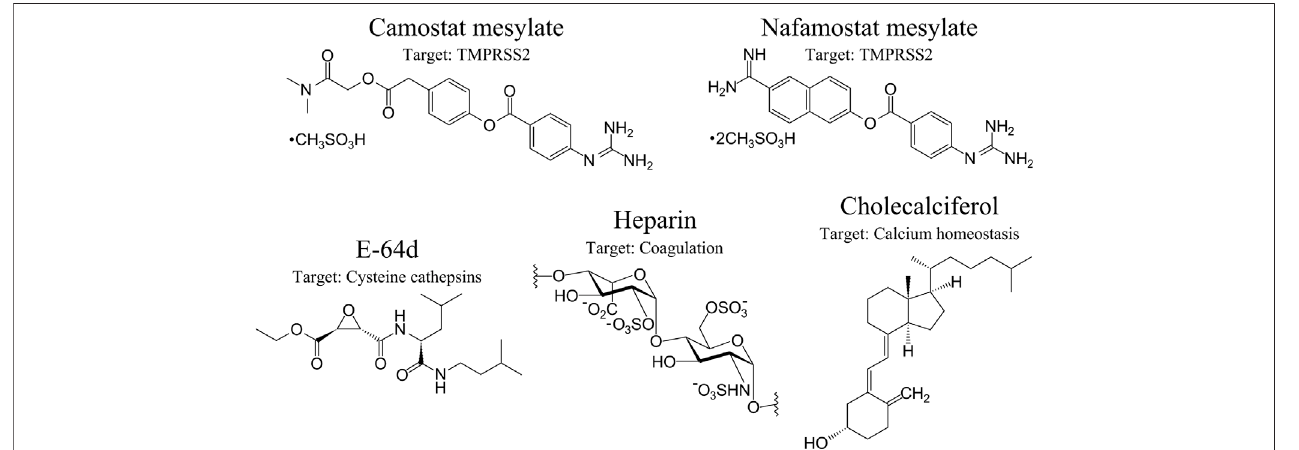
FIGURE4| TherapeuticoptioninthecontextofSARS-CoV-2andCOVID-19.Anti-SARS-CoV-2therapeuticoptionswithspeci fi ctargetsarepresentedfromleftto the right: Camostat, Nafamostat, aloxistatin/E-64d, heparin, and cholecalciferol (vitamin D 3 ). Their major protease targets are indicated. Protein-based inhibitors, including α -1 antitrypsin and aprotinin/bovine pancreatic trypsin inhibitor, are nlot shown.